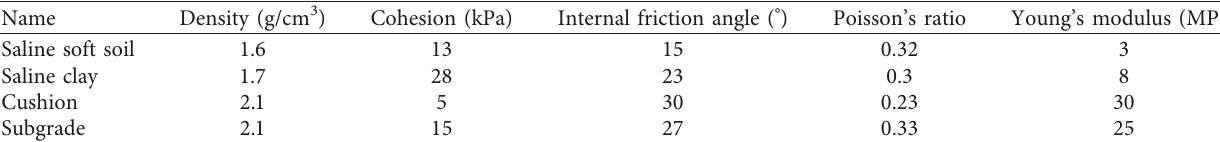
Figure 10: The initial model. (a) Foundation model. (b) Pile arrangement. Table 3: Soil material parameters.